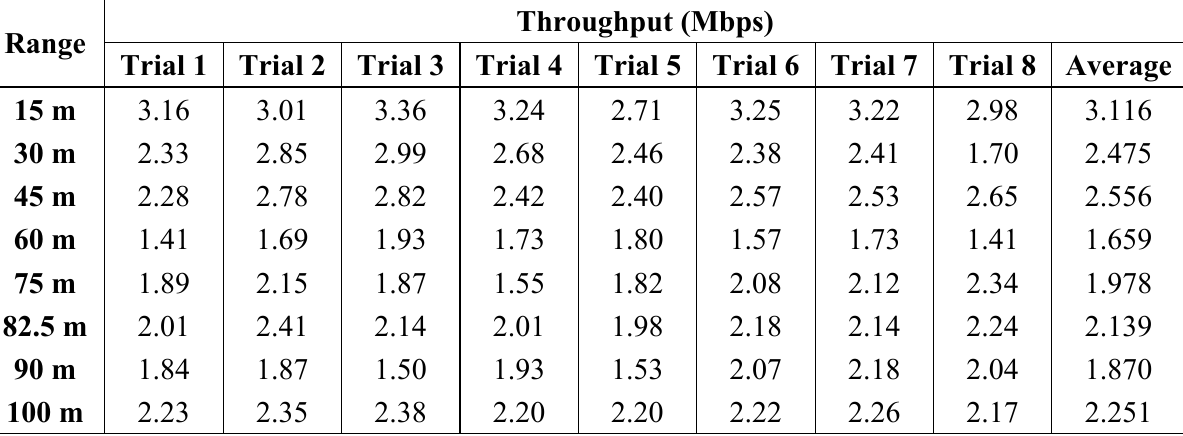
Table 1. The bandwidth results for the MP1–MP3 connection.